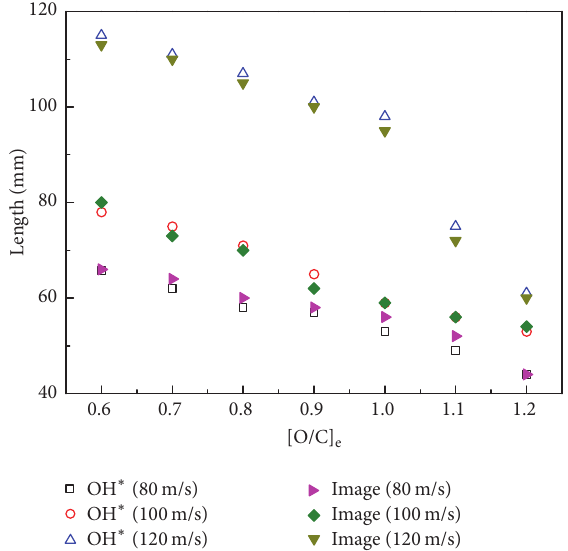
Figure 8: Comparison of flame luminous lengths obtained by OH ∗ emission and flame images.